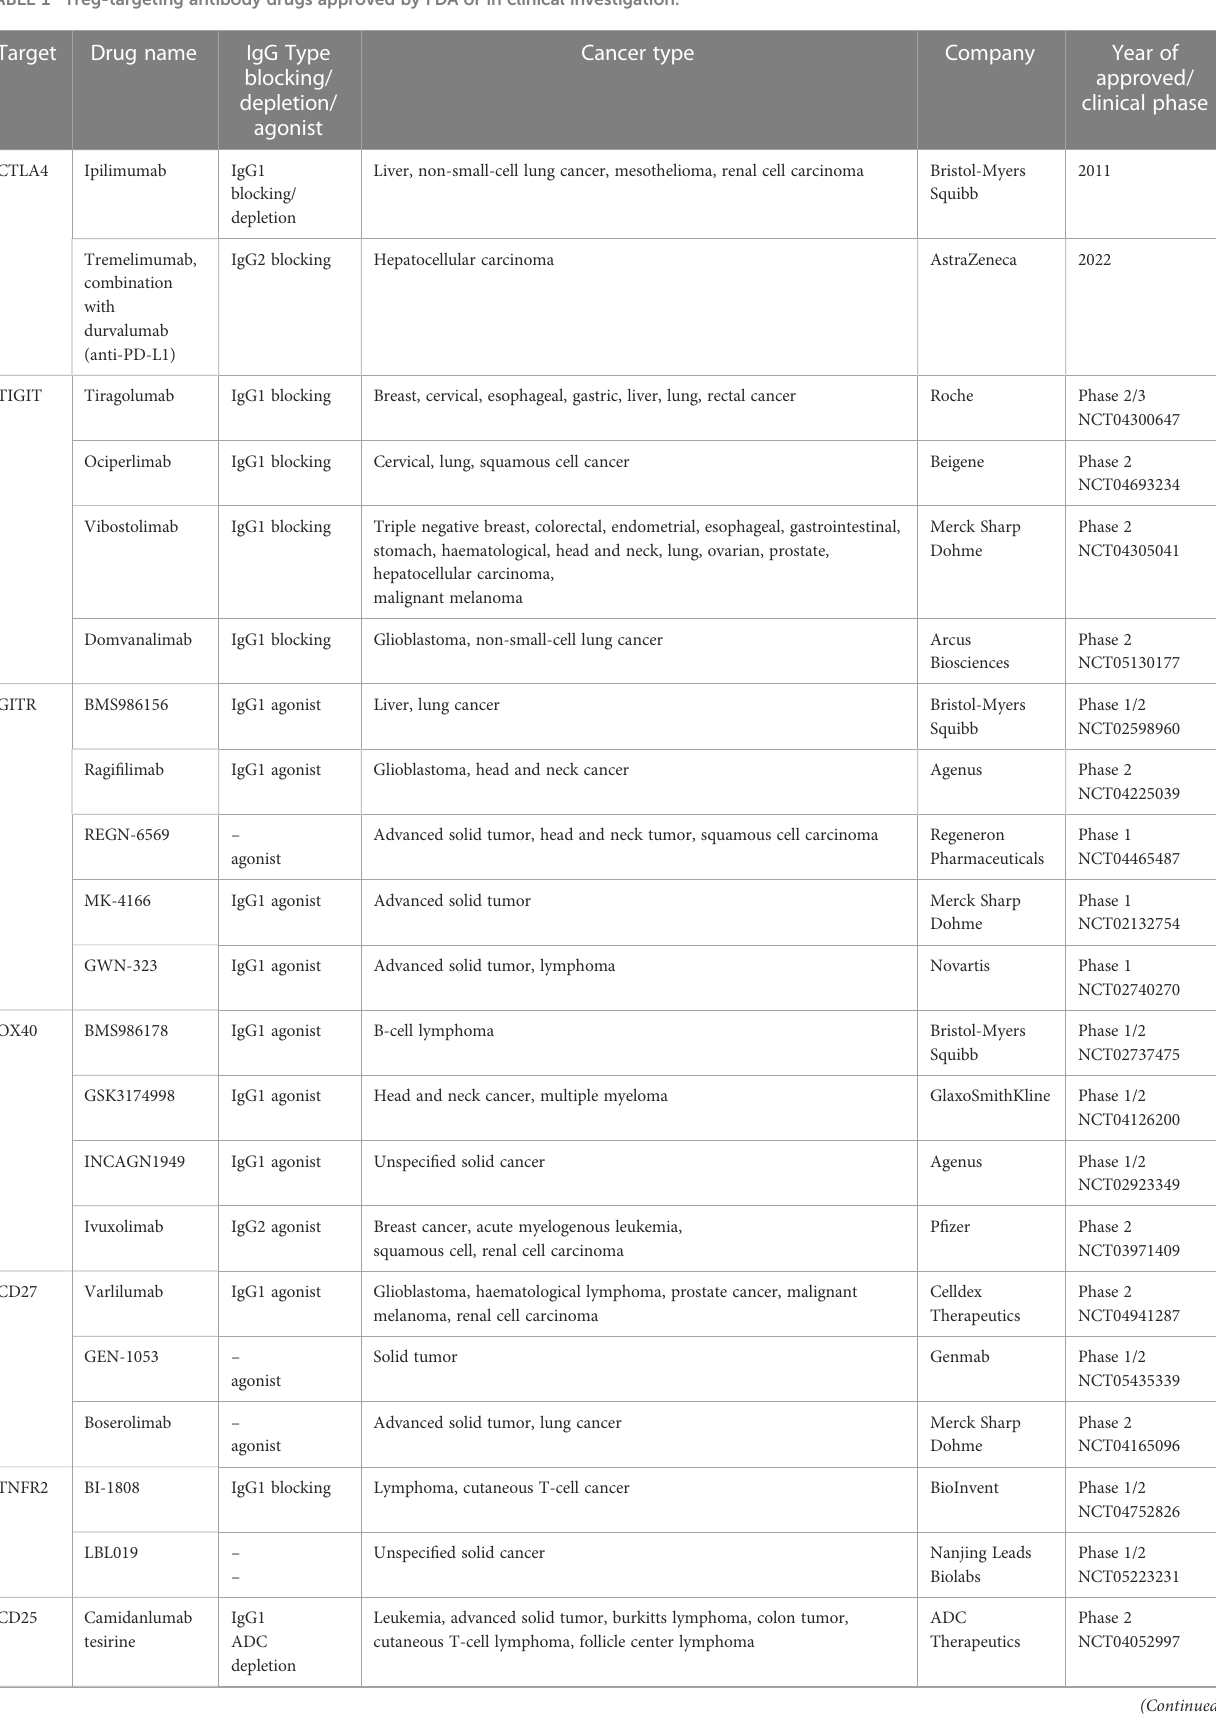
TABLE 1 Treg-targeting antibody drugs approved by FDA or in clinical